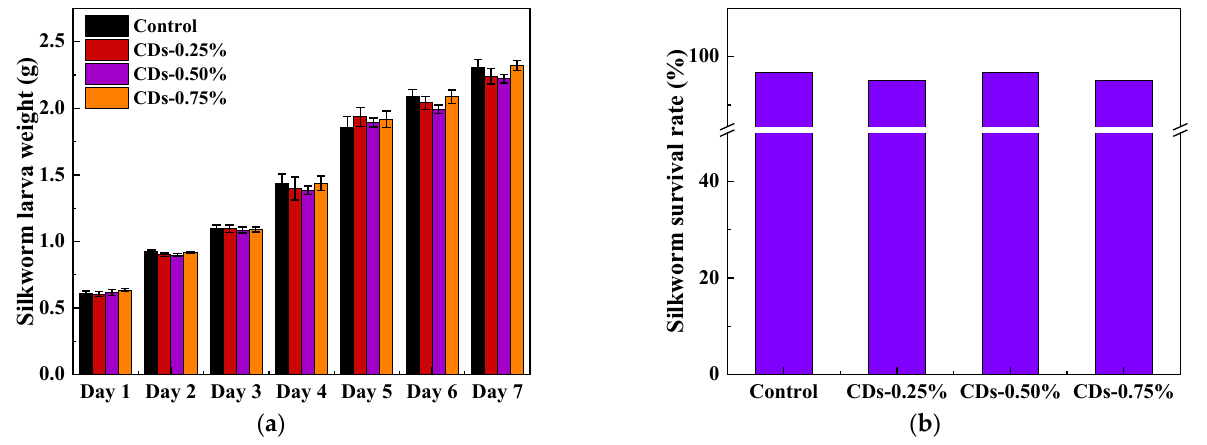
Figure 2. Effect of CDs on silkworm growth. ( a ) Weight of silkworm larvae from the first to the seventh day of the fifth instar. ( b ) Survival rate of silkworm larvae.